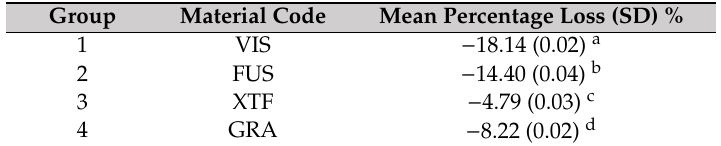
SD: standard deviation. Superscript letters (a, b, c and d) have been used to indicate statistical results: di ff erent letters among the groups indicate significant di ff erence in mean percentage loss among the groups (significance was set at P < 0.05). Table 4. Hardness ratio of each tested material.